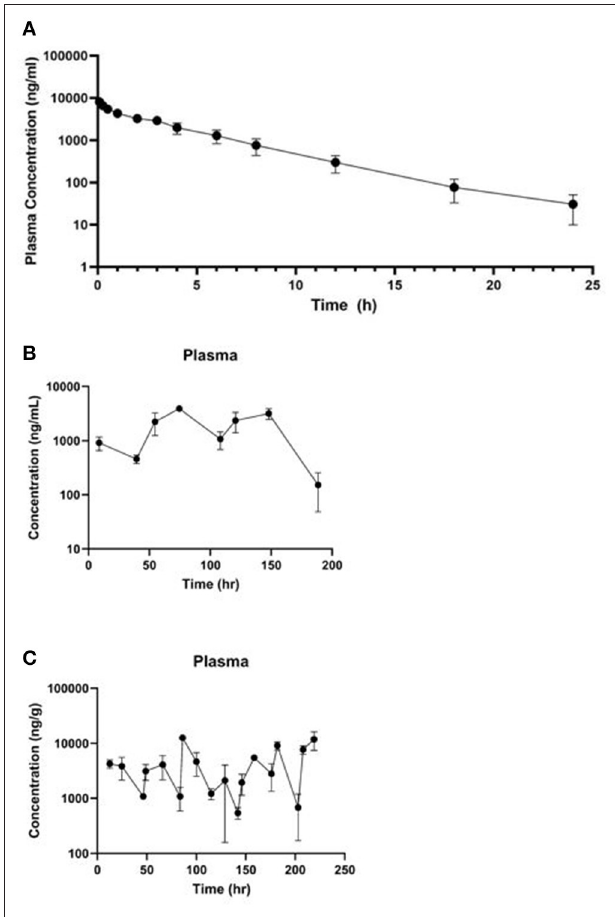
FIGURE 2 | Mean plasma ± standard deviation concentration vs. time curve collected (A) over 24h from four live animals following a single 1 mg/kg IV dose of meloxicam in chickens, (B) 188.5h after the first dose of a 1 mg/kg PO once daily for 8 dose regimen, and (C) 219h after the first dose of a 1 mg/kg PO twice daily for 20 dose regimen.